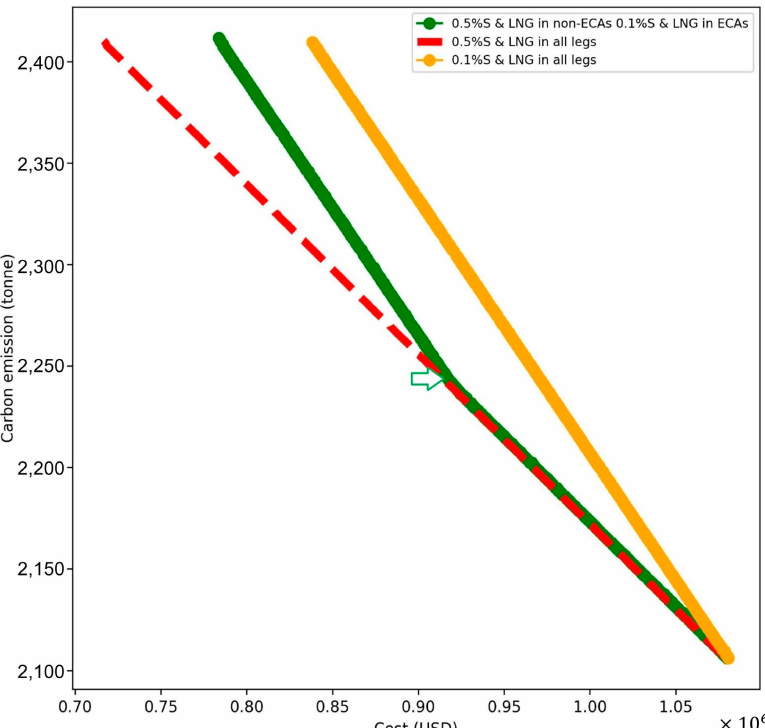
Figure 8. PFs (green solid, orange solid, red dashed) represent Scenario 3, Scenario 2, and considering 0.5% sulfur oil and LNG available in all legs, respectively. The green-frame arrow indicates the bending point of green PF.